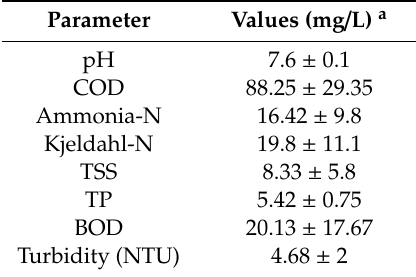
Table 1. Characterization of the secondary e ffl uents from the DWWTP (Betaniya, Israel) used in this